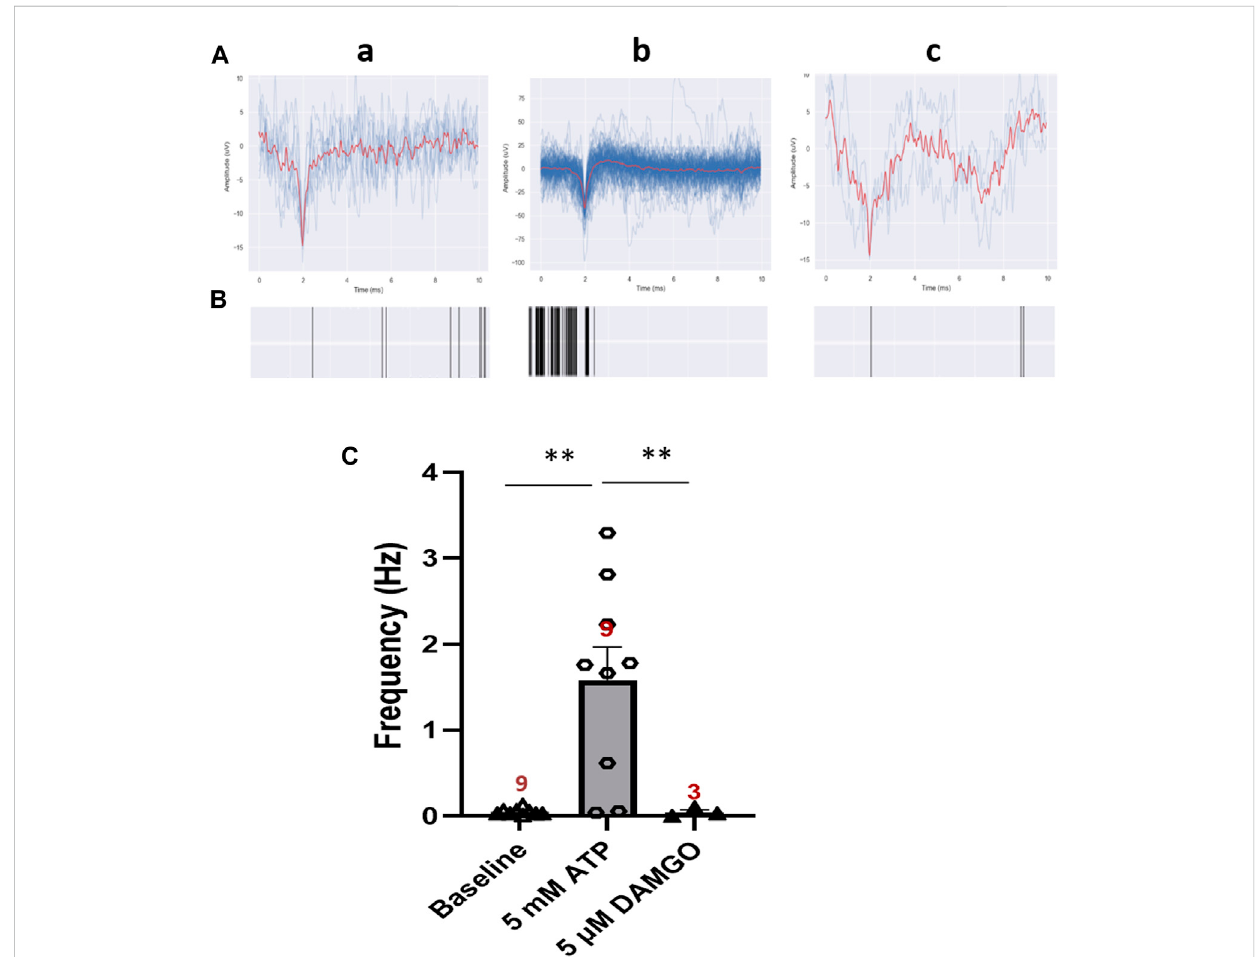
FIGURE 6 Inhibition effectofDAMGO onATP-inducedneuralactivityofiPSC-derivednociceptorsrecordedonMEAs. (A) Representative MEAactionpotential responses of iPSC-derived nociceptors demonstrating the inhibition of ATP-induced activity by DAMGO (5 μ M) a) baseline activity, b) activity after addition of ATP (5 mM) and c) activity after the subsequent addition of DAMGO (5 μ M). (B) Raster plot demonstrating the change of neural activity as described in (A) . (C) Graph of the neural activity change as described in (A) . Data presented are Mean + Standard Error. One-way ANOVA, * < 0.05; ** < 0.005). Number of biological replicates from at least three batches of experiments were indicated in each data bar in the